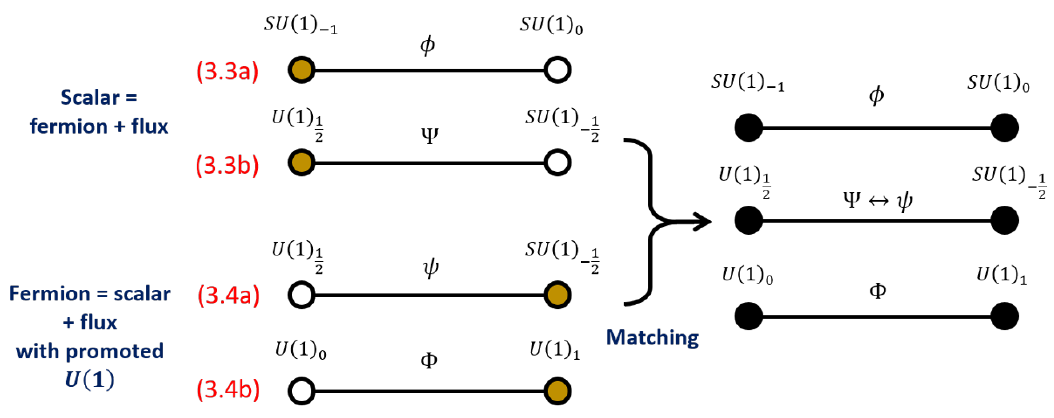
Figure 2 . Derivation of the bosonic particle-vortex duality as a duality between two-node linear quiver theories. On the left-hand side, we have represented each side of Aharony’s Abelian dualities as a two-node quiver. The (cid:12)lled yellow circle represents the color gauge group while the empty circle represents promoted global symmetries (which for the case of SU(1) are placeholders). The equation numbers corresponding to the two-node quivers are shown in red. Since the two fermionic theories are the same, one can perform a matching to arrive at a duality between three two-node quiver theories, the top and bottom of which are the XY and Abelian Higgs models,